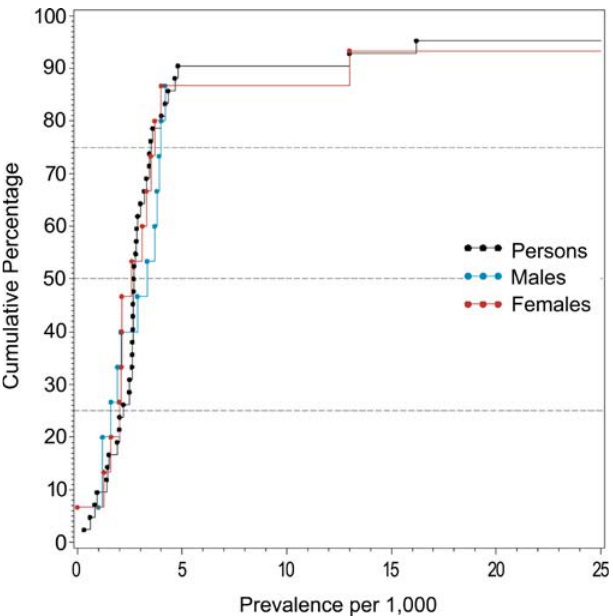
Figure 6. Cumulative Plots of the NOS Prevalence Estimates per 1,000 by Sex DOI: 10.1371/journal.pmed.0020141.g006